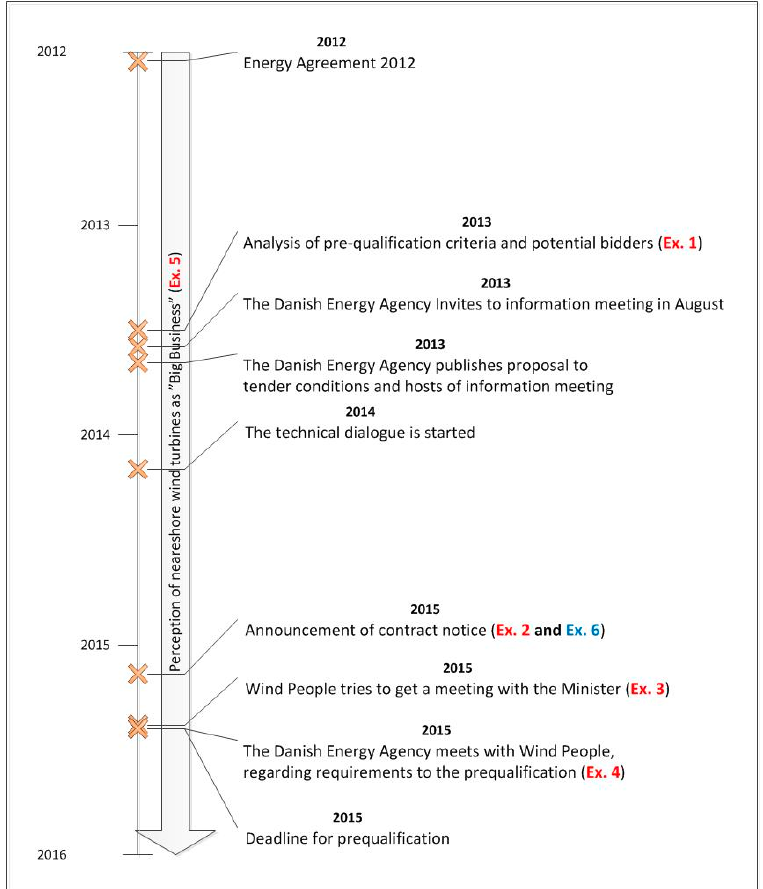
Figure 3. The tender process for the 350 MW nearshore wind turbines in Denmark taking its point of departure in key activities of the Danish Energy Agency. The timeline for the tender process is divided into several actions which have been important to the pre-selection of the bidders. It should not be seen as a complete timeline for the tender process, since, e.g., the interaction with different actors (others than Wind People) has not been identified. Some actions are marked with an example number and a color, which refer to examples of societal choice eliminating mechanisms as hindrances to the Wind & Welfare project. The red color refers to societal eliminating mechanism A and the blue color to societal eliminating mechanism B. Both the societal eliminating mechanisms and the examples are described in Table 1.